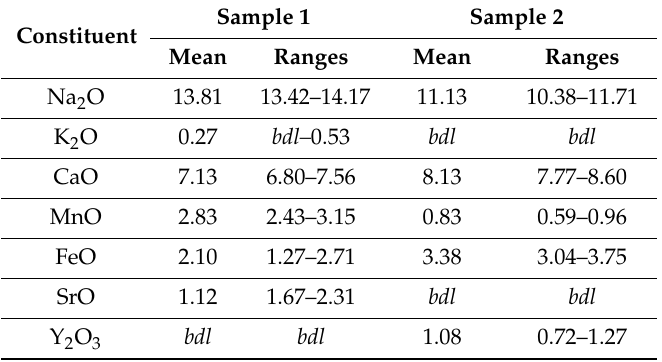
Table 2. Chemical composition of the studied Fe-deficient EGMs (in